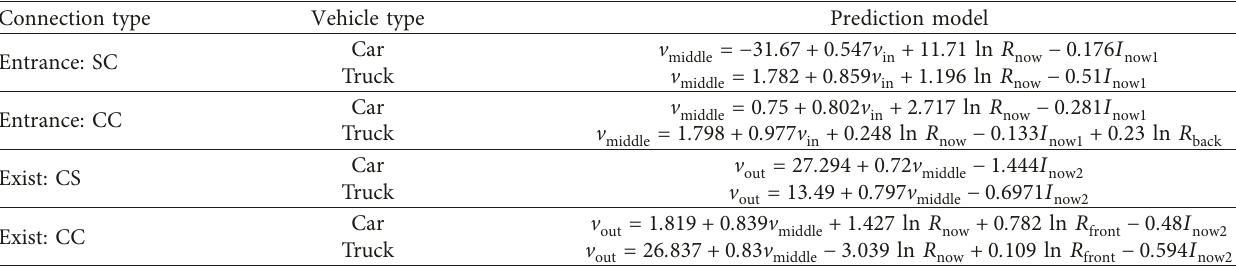
Table 10: Operating speed conversion model for curved slope